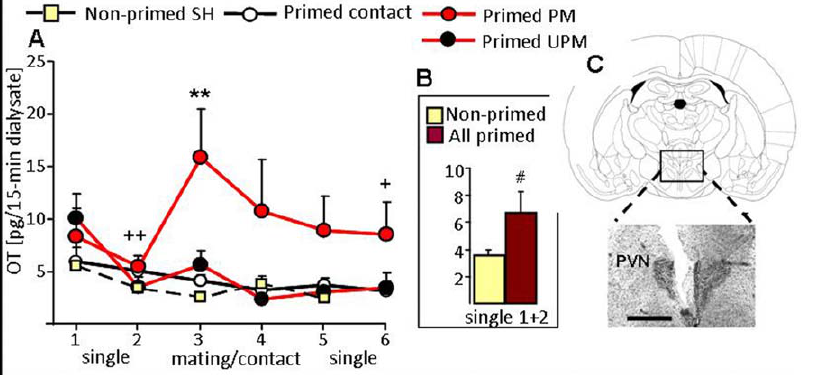
Figure 3. OT release within the PVN during UPM and PM in non-primed and primed female rats. ( A ) PM triggers OT release into the extracellular fluid of the PVN of primed female Wistar rats as indicated by elevated OT content in microdialysates sampled during exposure to a sexually experienced male. Two 15-min microdialysates were sampled during single-housing (dialysate 1, 2), physical contact with an unknown female (social contact), UPM or PM (dialysate 3, 4), and after removal of the female or male (dialysate 5, 6). ( B ) Mean OT content in dialysates sampled from all non-primed or primed females during single-housing (mean samples 1 and 2). ( C ) Schematic drawing at the level of the hypothalamic paraventricular nucleus (PVN; bregma 2 1.88 mm), and microphotograph of Nissl-stained coronal brain section after removal of the microdialysis probe located inside the PVN. Scale bar, 1.0 mm. Data represent means + S.E.M. ** P , 0.01 versus mating/contact all other groups, + P , 0.05, ++ P , 0.01 versus sample 3, primed PM group; and # P=0.06 versus mean basal of all non-primed SH